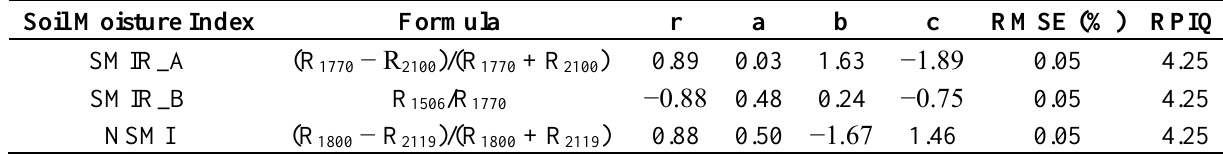
Table 2. Cross-validation results of novel soil moisture indices (SMIR_A and SMIR_B) and the normalized soil moisture index (NSMI), using data from MAC+SOLREFLIU datasets [13]. The equations of the soil moisture indices, Pearson’s correlation coefficient (r), the coefficients of the quadratic regressions (Soil moisture = a + b*index + c*index 2 ), the root mean square error (RMSE) and the ratio of the performance to the interquartile range (RPIQ) are reported.